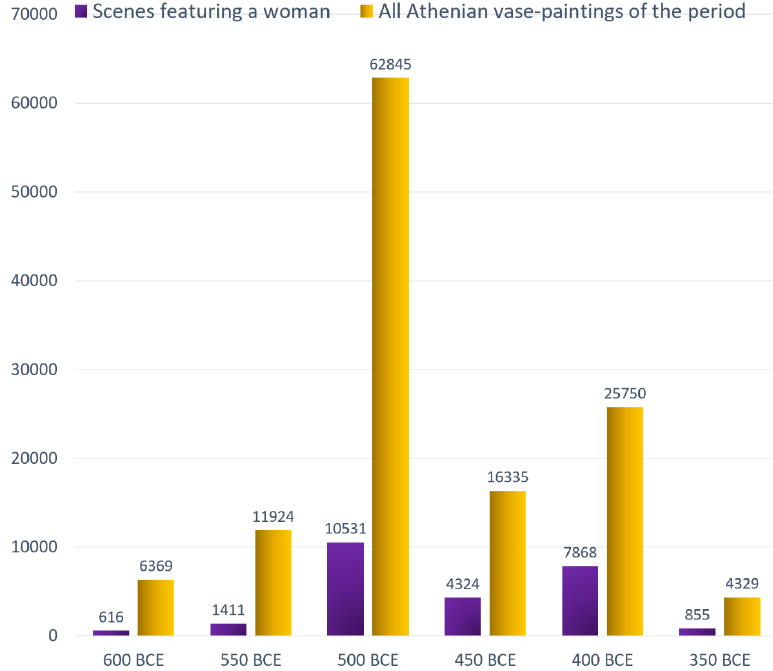
Figure 6. Number of vases featuring women and overall numbers of Athenian vases. Data from the BAPD. Chart created by author.